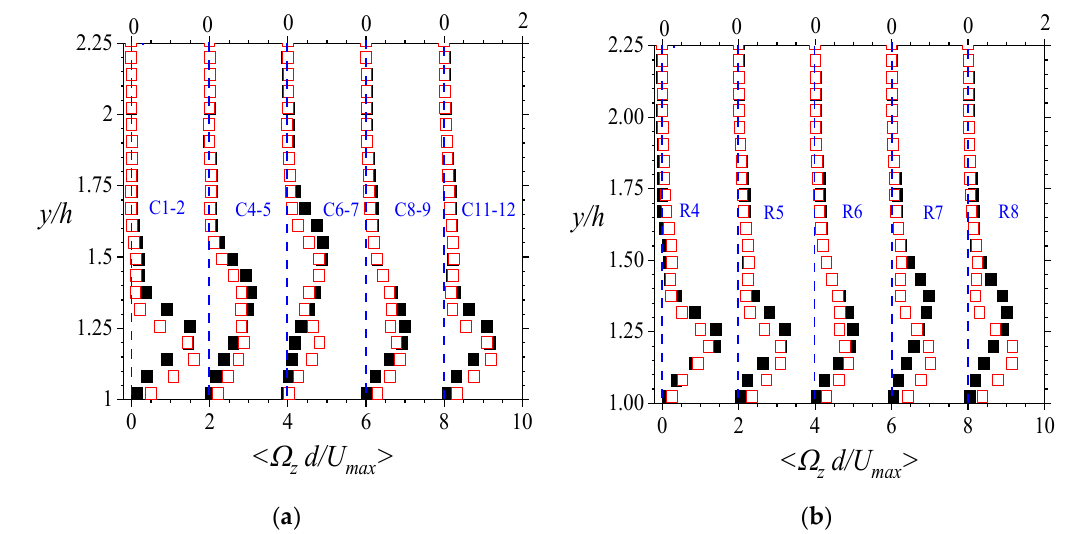
Figure 14. Line-averaged mean spanwise vorticity < Ω z > = < ∂ V / ∂ x − ∂ U / ∂ y > plots normalized by the ratio of the local maximum line-averaged streamwise mean velocity and rod diameter. Plots in ( a ) are staggered distributions along the stream, and those in ( b ) are staggered across the span in the open region. The denominations C and R respectively stand for columns and rows, and are illustrated in Figure 1. Black-filled boxes are the results for Test A , and red-open boxes are the results for Test B .